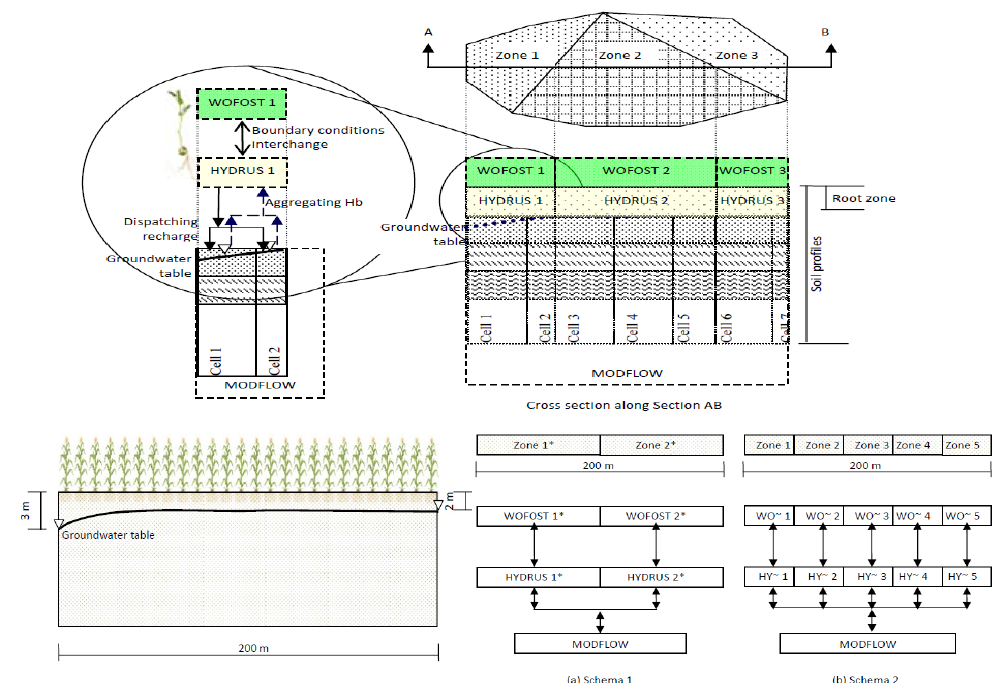
Figure 1. The conceptual model and a 2-D hypothetical simplified scenario with two spatial discretizing schemas.